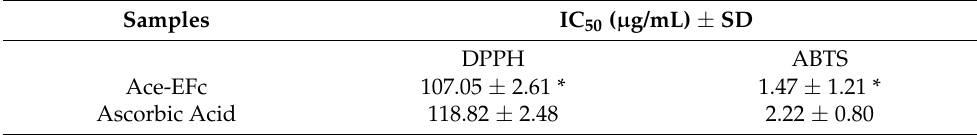
Table 2. IC 50 for DPPH and ABTS free radical scavenging activity of Ace-EFc.